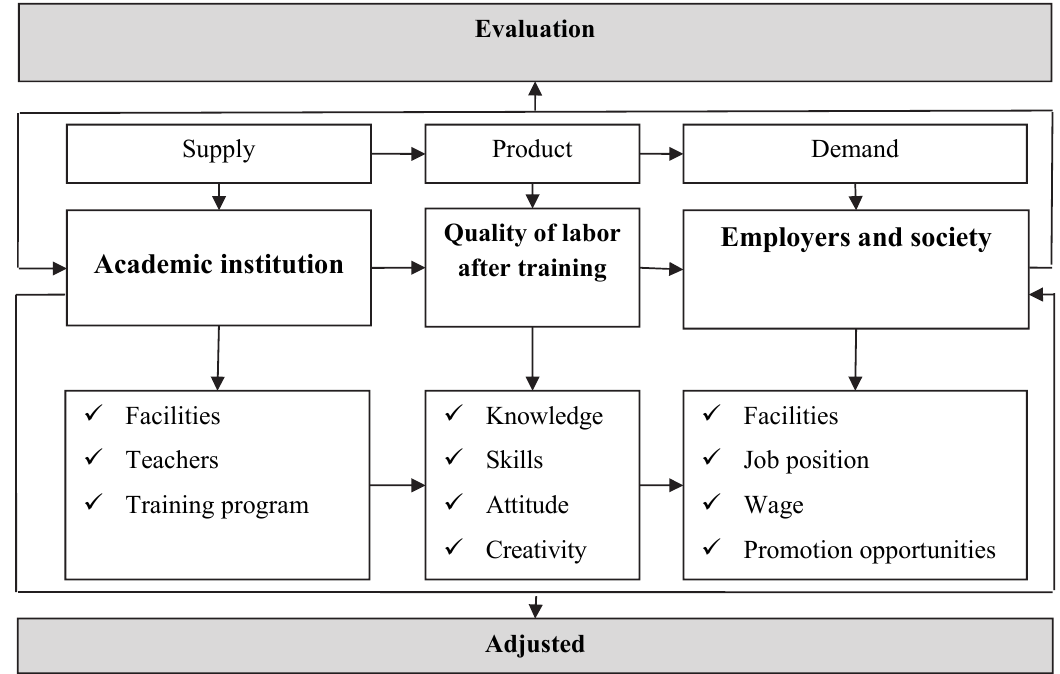
Fig. 1 The relationship between institution, student and